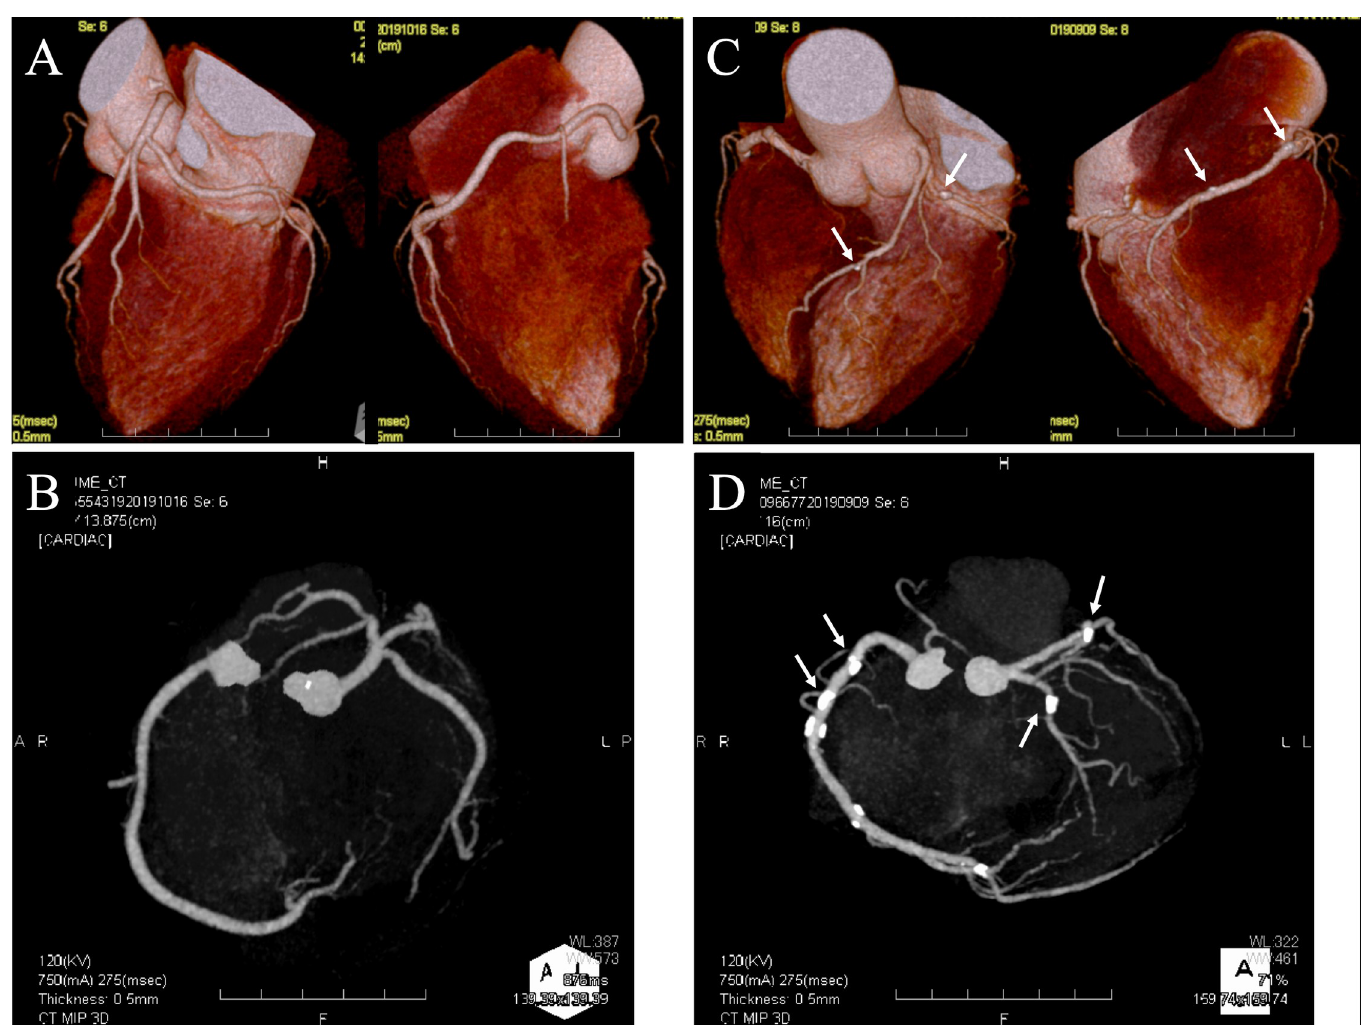
Fig 1. Representative case. (A) Three-dimensional (3D) reconstruction and (B) axial computed tomography image showing no coronary artery calcification (CAC). (C) 3D reconstruction and (D) axial image showing CAC; #1, #2, #6, and #11 are highly calcified. The number of CAC sites was 4